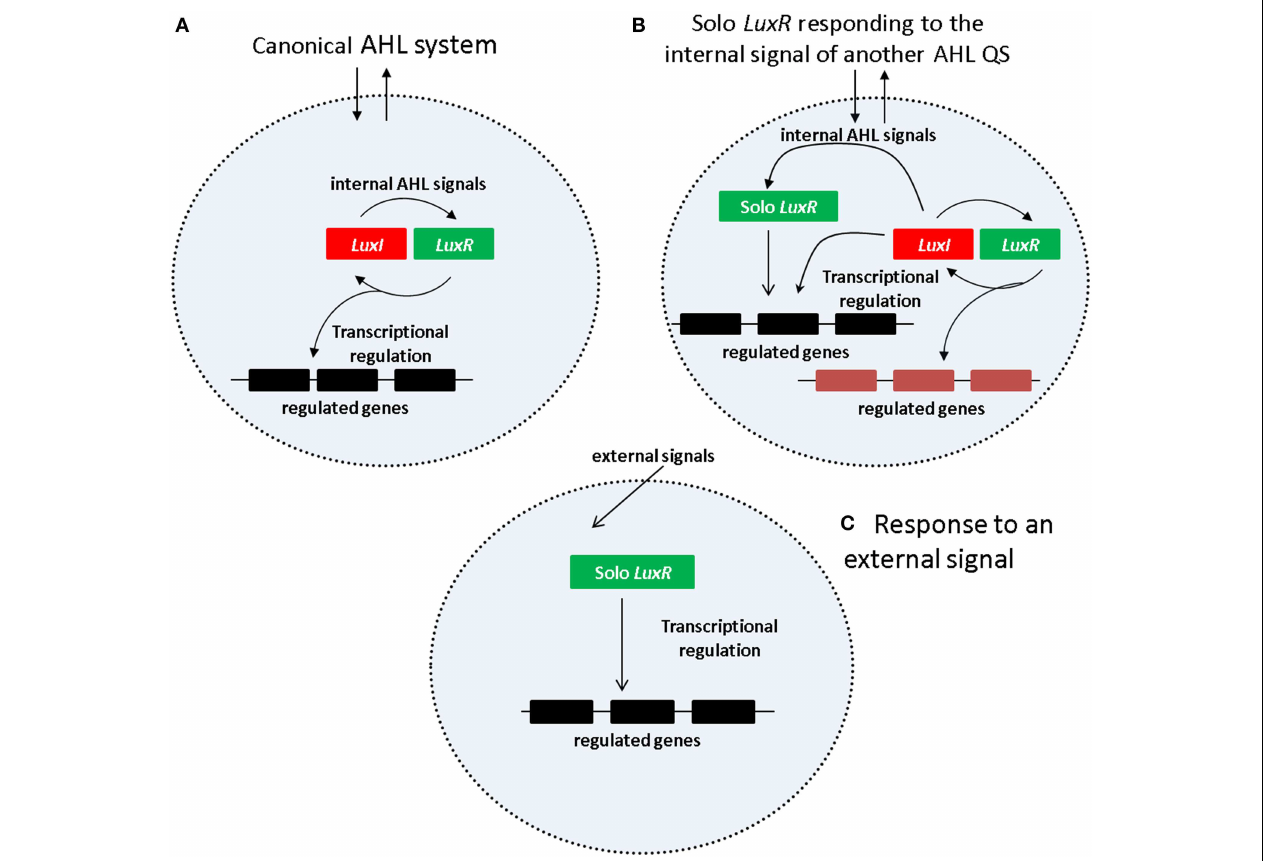
FIGURE 1 | Regulatory mechanism of AHL QS system. (A) Canonical AHL system. (B) Solo LuxR responding to the signal of a nonadjacent LuxI synthase. (C) Solo LuxR responding to an external